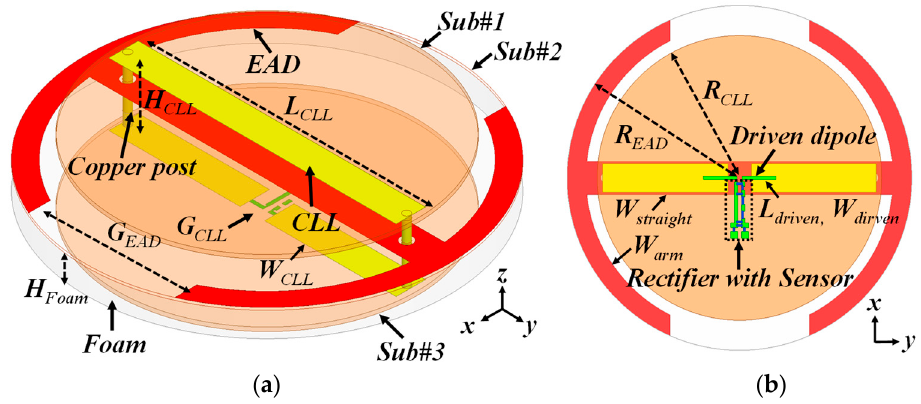
Figure 8. Electrically small ( ka ≈ 0.73) Huygens antenna integrated with the sensor-augmented rectifier circuit: ( a ) perspective view and ( b ) bottom view.